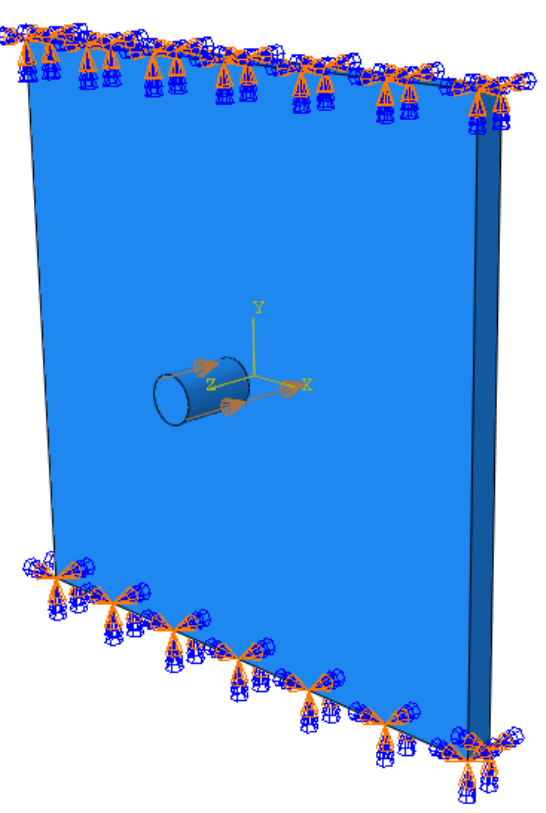
Figure 5. Depiction of Impact Simulation Loading and Boundary